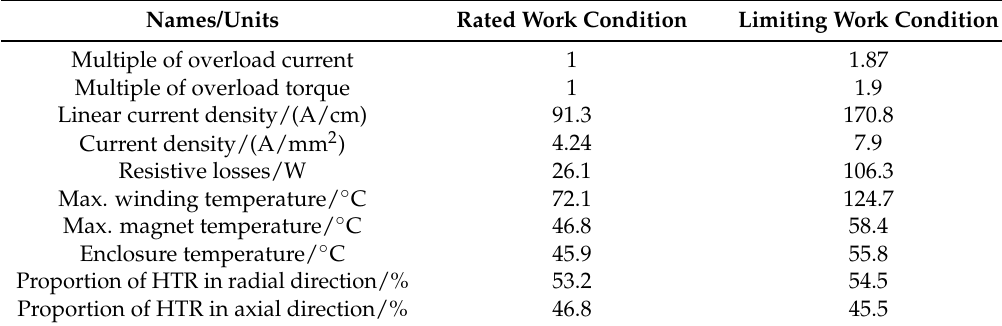
Table 7. Parameter comparison of the two work